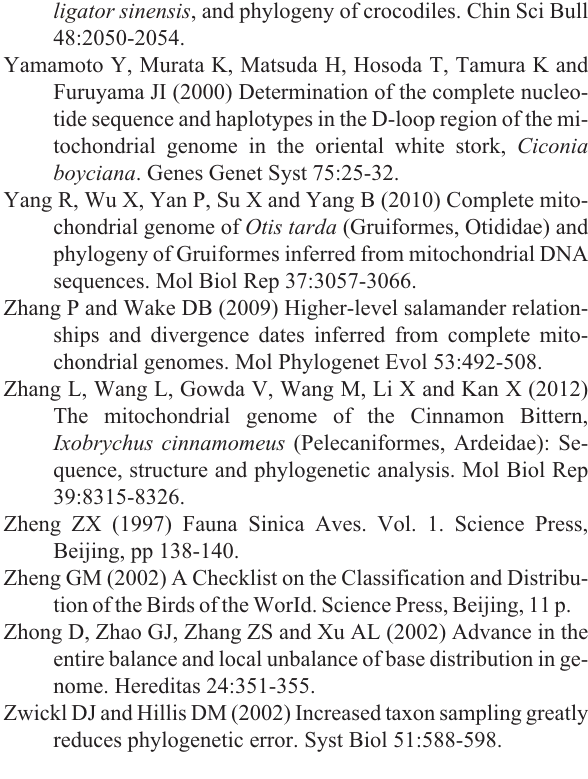
Table S2 - Codon usage in the mitochondrial genome of E. garzetta. Table S3 - Pairwise distances of 11 species inferred from the mitochondrial